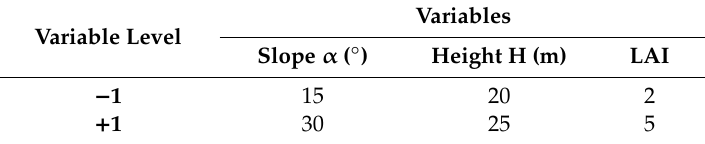
Table 3. Variables and their corresponding values used in the design of experiments (DoE) study.